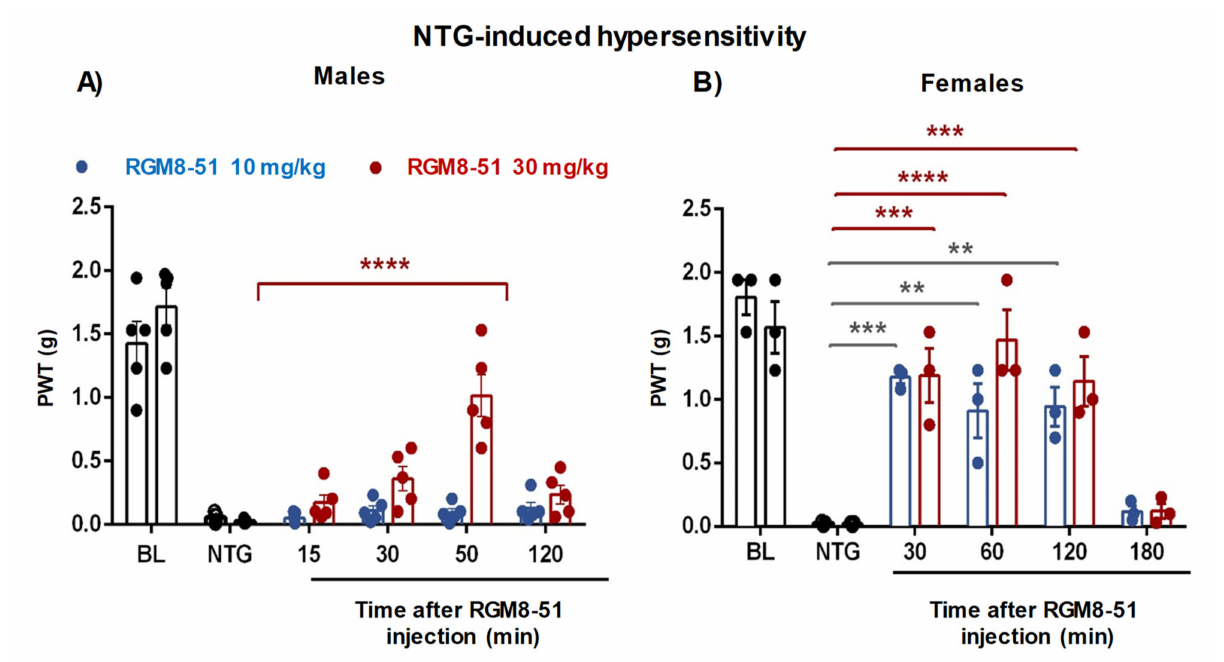
Figure 8. β –lactam RGM8-51 reduces NTG-induced hypersensitivity in a sex-dependent manner. ( A ) Paw withdrawal threshold (PWT) increased dose-dependently in C57 male mice 2 h after injection of 30 mg/kg of NTG. ( B ) NTG-induced mechanical hypersensitivity was fully blocked in female mice by the systemic injection of RGM8-51 compound in a dose dependent manner. Compound RGM8-51 was intraperitoneally injected 2h after NTG injection and 30 min before von Frey measurements. Data are given ± SEM (n = 3–5). Statistical analysis was two-way ANOVA followed by post hoc Bonferroni test by multiple comparison ** p < 0.05; *** p < 0.001; **** p <